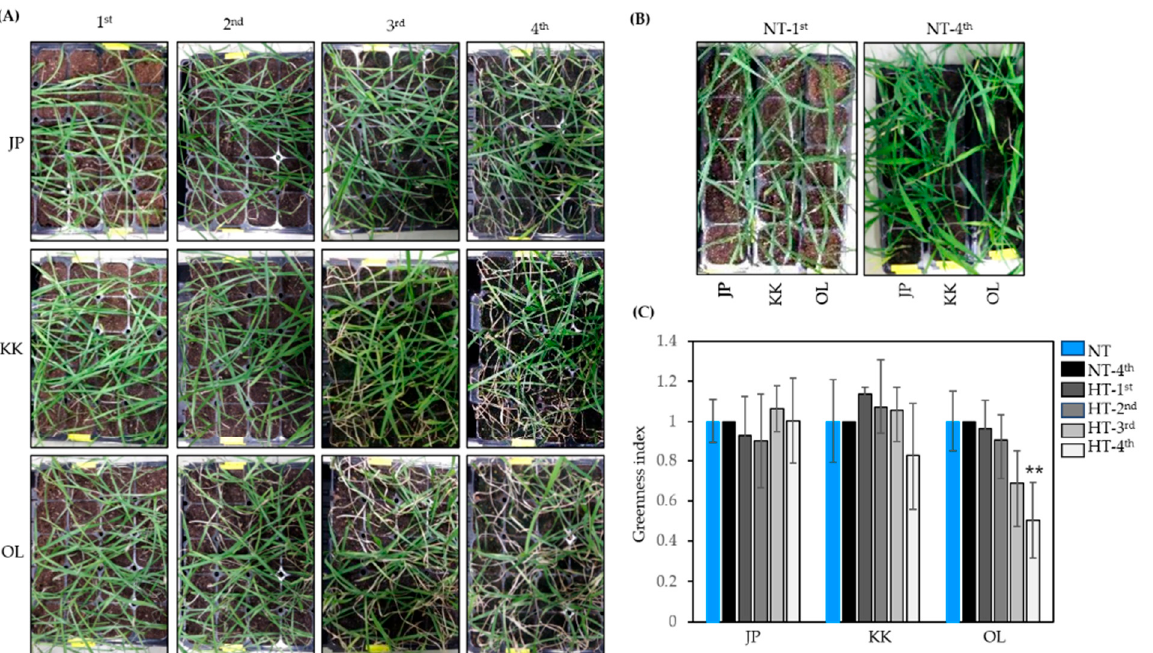
Figure 1. Evaluation of heat stress in three wheat varieties. ( A ) Plant growth after repeated heat treatment at 45 °C for 3 h; ( B ) plant growth at 22 °C; ( C ) greenness index after heat treatment on seedlings of Jopum, Keumkang, and Olgeuru. NT, no-heat treatment; HT, Heat treatment; JP, Jopum; KK, Keumkang; OL, Olgeuru. The 1st, 2nd, 3rd, and 4th indicate repeating 1st, 2nd, 3rd, and 4th heat treatments at 45 °C for 3 h. Asterisks indicate significant differences at p < 0.01 (**) as calcu- lated using Student’s t -test.